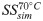
Model validation.Comparison between SSsim70°C and SS70°C for metabolite and flux steady states. A-B) Pie Chart. Inner circle: percentual contribution of each metabolite (A) or flux (B) steady states to the overall steady state at 70°C (SS70°C); Outer circle: percentual contribution of each metabolite (A) or flux (B) steady states to the overall steady state at 70°C (SSsim70°C) (0% contributions ignored); C-D) Bar Chart comparing the metabolite and flux steady states for SSsim70°C (Orange Bars), SS70°C (dark red bars) and the relative ratio between SSsim70°C and SS70°C (blue bars). The left y-axis refers to the SSsim70°C and SS70°C and the right y-axis (blue) refers to the relative ratio rc. C) Metabolite; D) Flux.